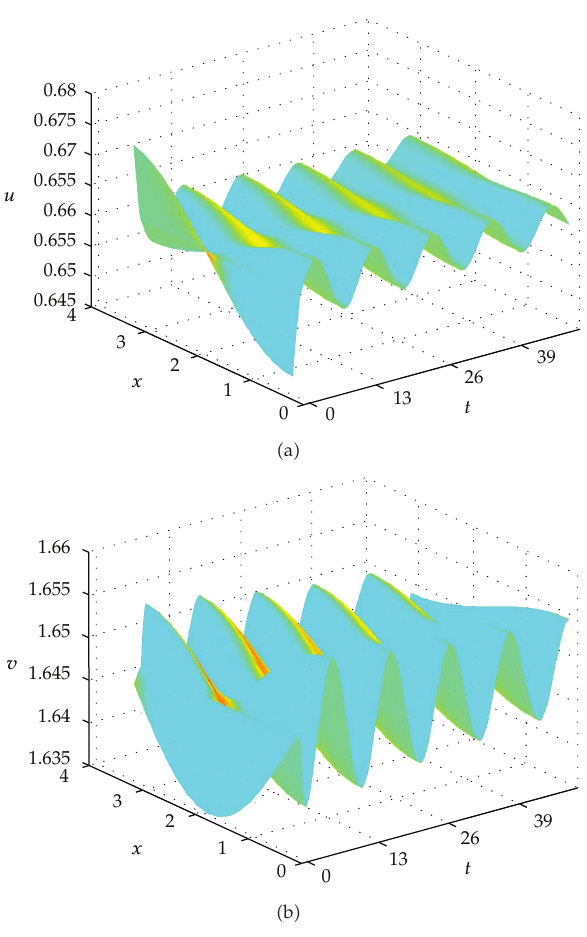
Figure 3: The solution of system (cid:6) 1.7 (cid:7) tends to aperiodic orbit. The parameters are taken as α (cid:5) 2, β (cid:5) 0 . 2, γ (cid:5) 0 . 5, b (cid:5) 2, c (cid:5) 3, m (cid:5) 1, d 1 (cid:5) 0 . 01, d 2 (cid:5) 0 . 1, τ (cid:5) 1 . 3, and the initial values u (cid:6) x,t (cid:7) (cid:5) 0 . 662 (cid:8) 0 . 01 t cos x , v (cid:6) x,t (cid:7) (cid:5) 1 . 649 (cid:8) 0 . 01 t sin x , and t ∈ (cid:3) − 1 . 3 , 0 (cid:4) , x ∈ (cid:3) 0 ,π (cid:4) . In this case, τ > τ 0